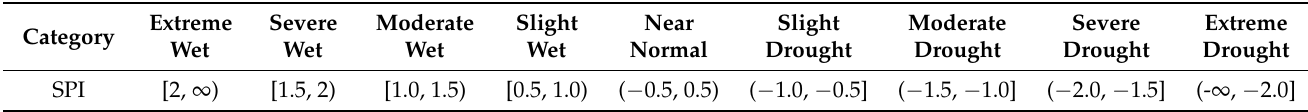
Table 1. SPI and drought classifications according to the Chinese meteorological grading